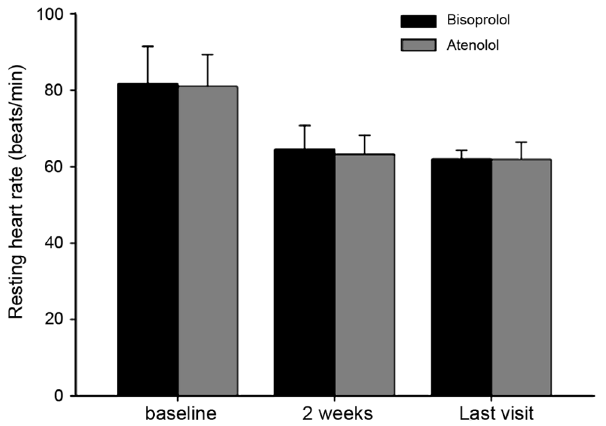
Table 4. Changes in HRV from baseline to the end of treatment in the bisoprolol and atenolol groups (ITT).